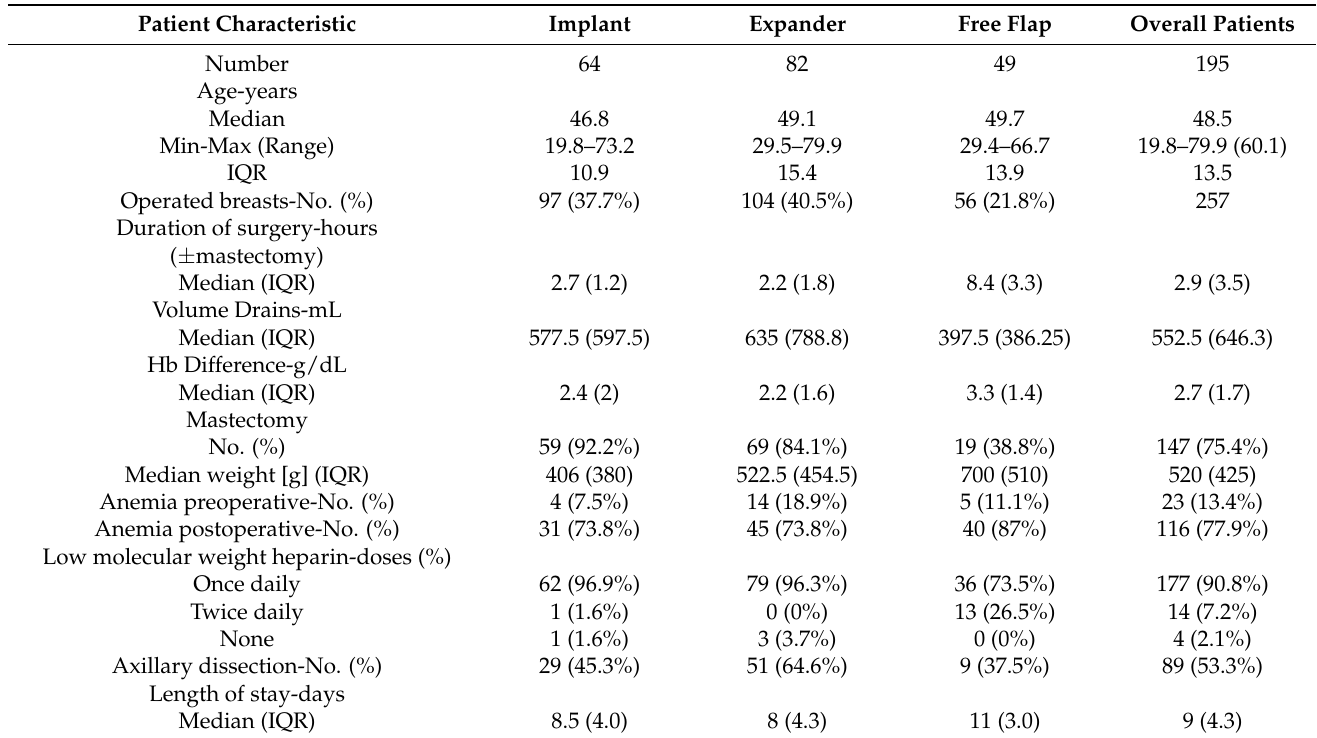
Table 1. Baseline characteristics of patients: significantly higher drainage volumes were seen in prosthetic-based breast reconstruction (577.5 mL in definitive implant patients, 635 mL in